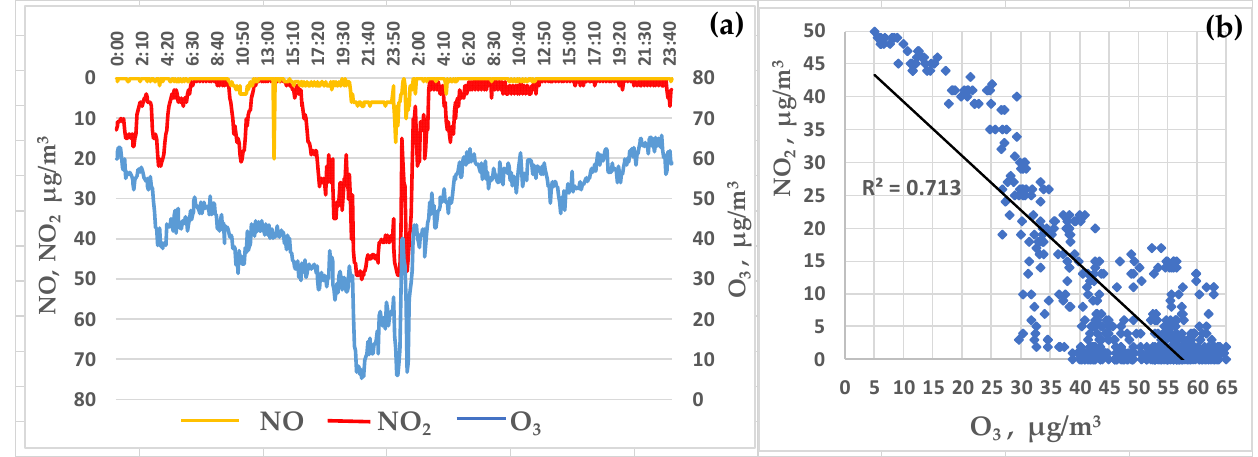
Figure 4. An example of a five-minute recording of the concentrations of ozone and nitrogen oxides at the Listvyanka station ( a ) during the transport of the plume from the remote thermal power plant above the Listvyanka monitoring station on 27–28 November 2021 and the scattering diagram ( b ).